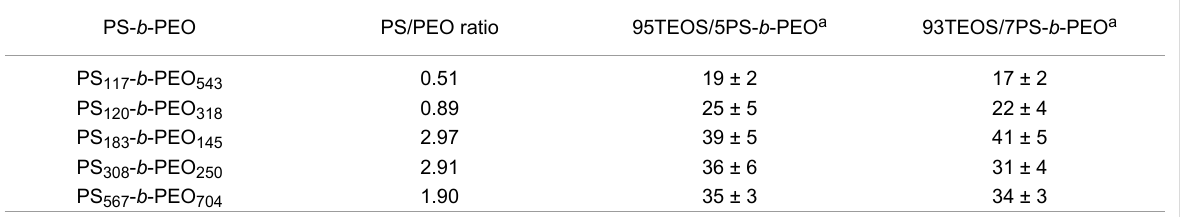
Table 1: Average pore size calculated from HRTEM